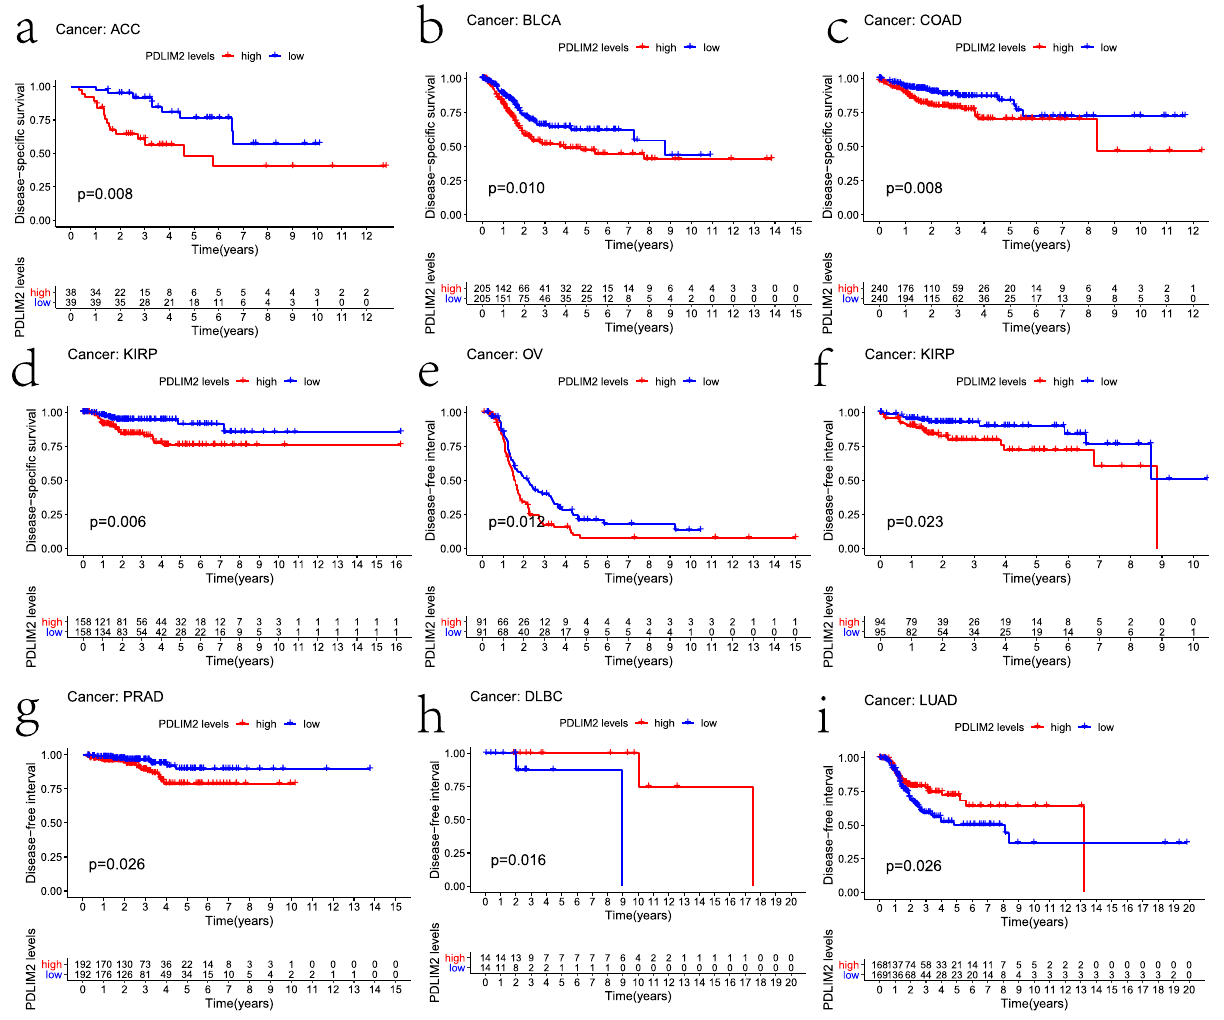
Vienna, Austria), ( a ) DSS survival curves of ACC, ( b ) DSS survival curves of BLCA, ( c ) DSS survival curves of COAD, ( d ) DSS survival curves of KIRP, ( e ) DFI survival curves of OV, ( f ) DFI survival curves of KIRP, ( g ) DFI survival curves of PRAD, (h)DFI survival curves of DLBC, ( i ) DFI survival curves of LUAD. ACC: adrenocortical carcinoma; BLCA: bladder urothelial carcinoma; COAD: colon adenocarcinoma; KIRP: kidney renal papillary cell carcinoma; OV: ovarian serous cystadenocarcinoma; KIRP: kidney renal papillary cell carcinoma; PRAD: prostate adenocarcinoma; DLBC: lymphoid neoplasm diffuse large B-cell lymphoma; LUAD: lung